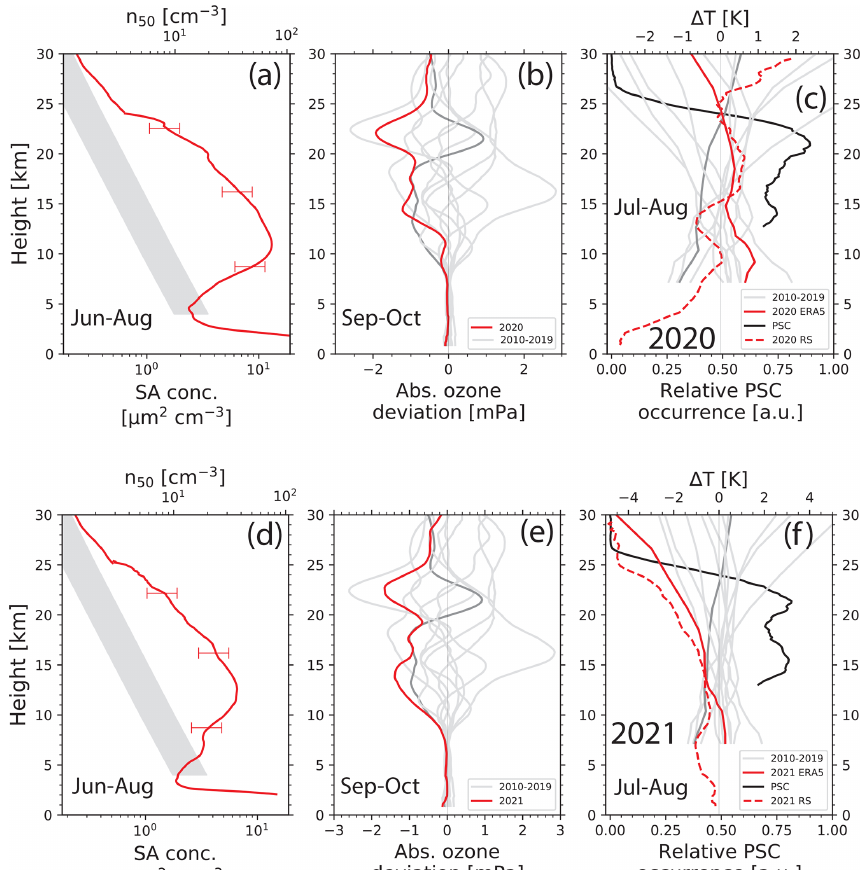
Figure 7. (a) Winter (June–August) mean profiles of the particle surface area (SA) concentration and number concentration n 50 (particles with radius > 50nm) estimated from lidar observations at Punta Arenas in 2020. Horizontal red bars indicate a SA retrieval uncertainty of 35%. Background aerosol conditions are given as a gray shaded area (based on lidar observations at Lauder, New Zealand) (Sakai et al., 2016). (b) Additional ozone loss (red profile) for September–October 2020, i.e., absolute ozone deviations from the respective long-term September–October (2010–2019) mean profile (see Eq. 1). Respective ozone deviations for the individual years from 2010–2019 are given as light gray profiles, and the 2015 deviations (Calbuco year) are highlighted as a dark gray profile. (c) PSC height range (restricted to heights > 13km) and relative vertical distribution of the PSC frequency of occurrence (in arbitrary units) from CALIOP observations and mean temperature deviations (2020 ERA5 mean values for the 70–90 ◦ S latitudinal belt, solid red profile); ozonesonde/radiosonde values (2020 RS, dashed red profile) for the main PSC months July–August 2020 from the respective July–August long-term mean profile (calculated with Eq. 4). Respective temperature deviation profiles (based on sonde data) for the individual years from 2010–2019 are given as light gray lines, and the 2015 profile (Calbuco eruption) is highlighted as dark gray line. Ozone- and radiosonde data collected at the Neumayer and South Pole stations are used (averaged) in the ozone and temperature calculations (2020 RS data). (d) – (f) Same as (a) – (c) except for